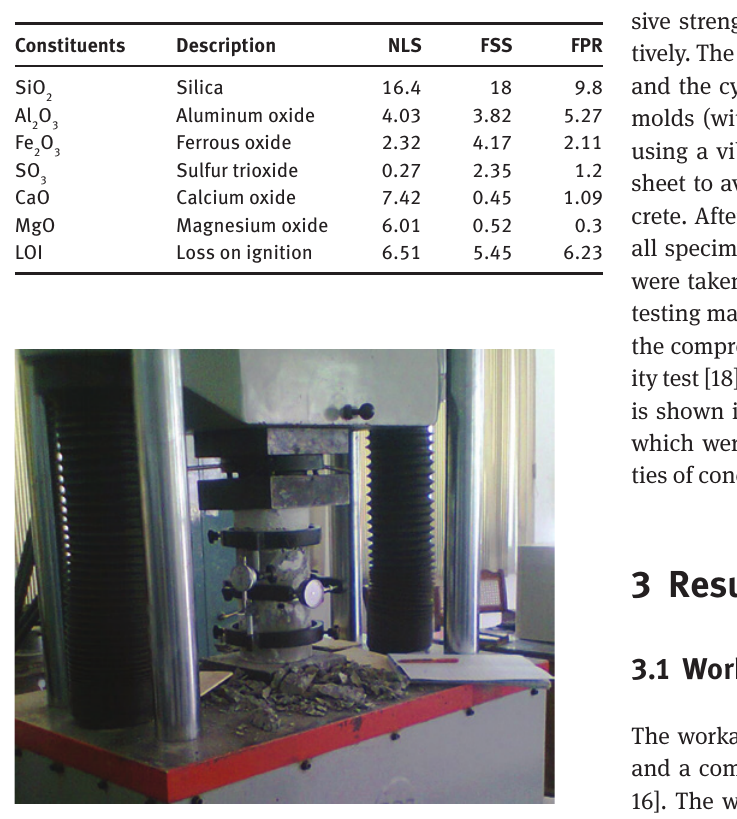
Table 2: Chemical oxide percentages of all types of sands.